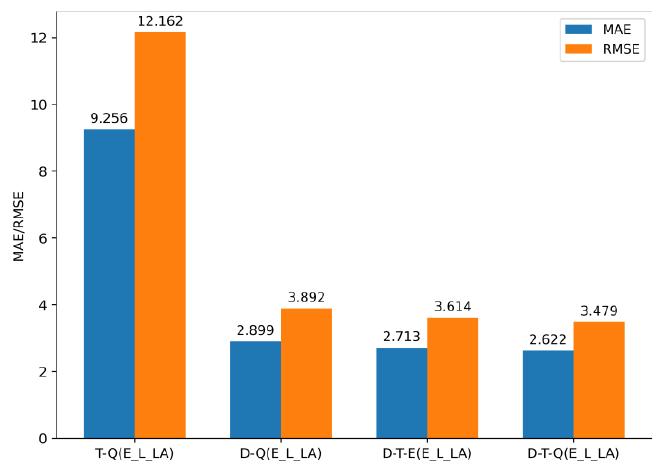
Figure 11. Prediction errors across models.